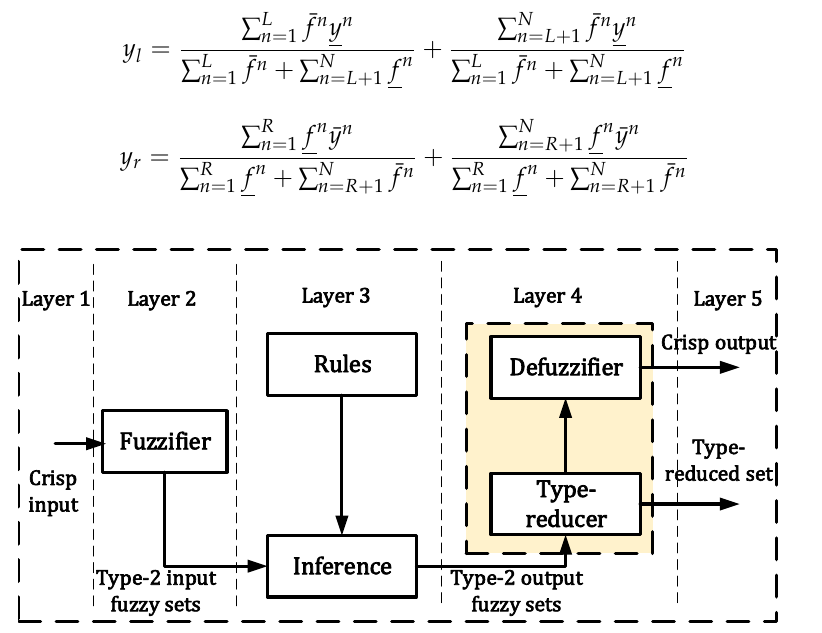
Figure 2. The block-diagram of Type-2 Neuro-Fuzzy